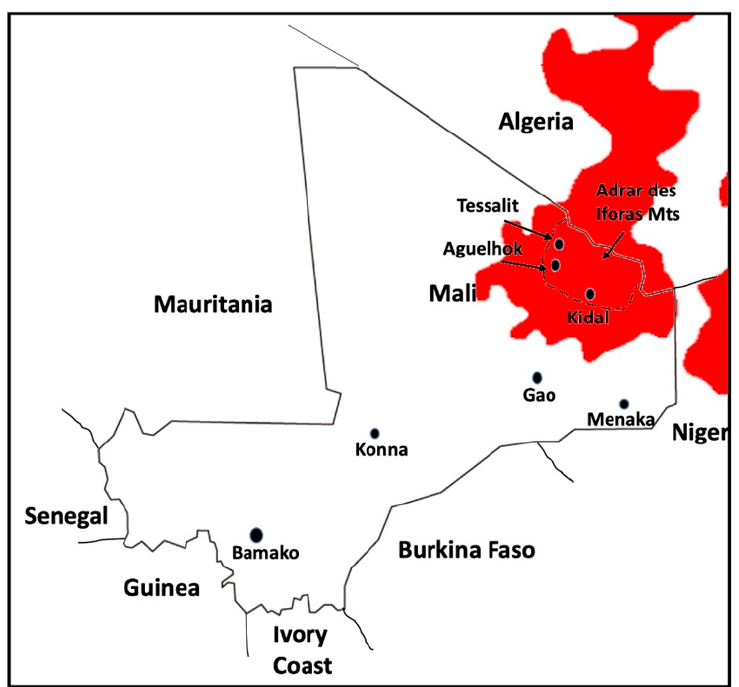
Figure 10. Locations and regions mentioned in the text in relation to desert locust activity and in- Scheme 2006. A Tuareg insurgency intensified when government army bases in Kidal, Menaka, and Tessalit (Figure 10) were attacked, but the conflict was resolved two months later [59,60]. In late 2011, another Tuareg rebellion began, strengthened by mercenaries from the Libyan civil war [59–61], and sporadic violent Tuareg unrest has continued through 2020.